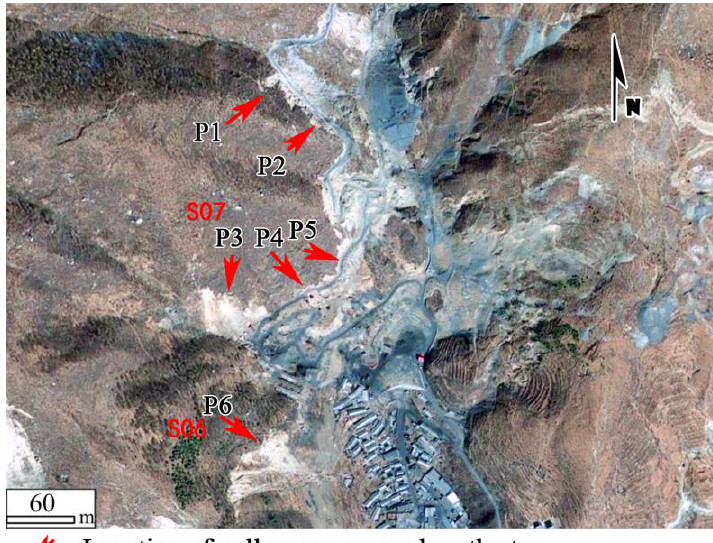
Figure 14. Optical image of Landslide S06 and S07 in 2009. P1, P2, P3, P4, P5 and P6 denote collapses that occurred on the toe.